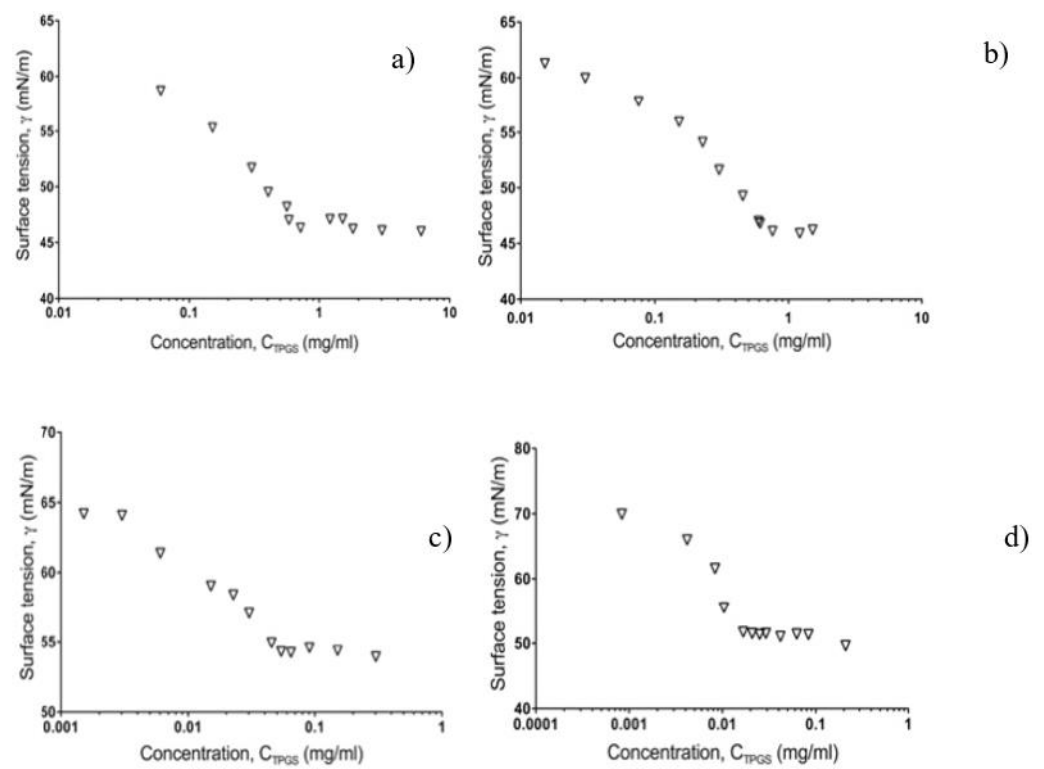
Figure 4. Surface tension isotherms of mixed systems ( a ) C 7 CO-HTMG / TPGS, ( b ) C 9 CO-HTMG / TPGS, ( c ) C 11 CO-HTMG / TPGS, and ( d ) C 13 CO-HTMG / TPGS at di ff erent molar ratio. Table 3. Composition of the mixtures used for the preparation of CnCOPILs / Nano and CnCOPILs-TPGS / Nano along with the related physico-chemical parameters, hydrodynamic diameter (D h ) at two di ff erent angles, 62.6 ◦ and 90 ◦ , and polydispersity index (P.I.); n.d.: not detectable. D h Formulation Concentration (nm) FA-PIL CnCOPILs / Nano mM